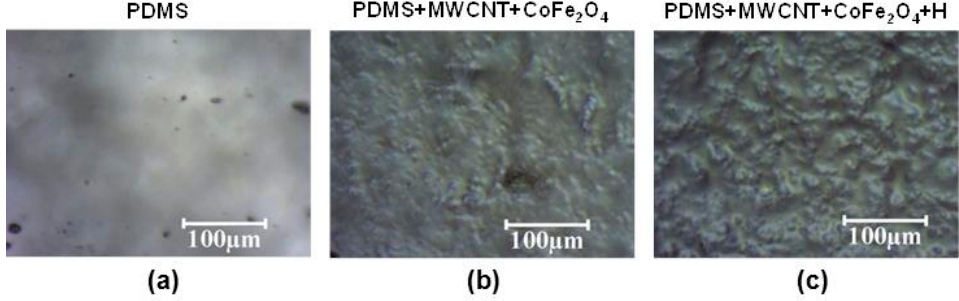
Figure 2. Optical microscopies: ( a ) PDMS. ( b ) PDMS + MWCNT (1%) + Fe 2 CoO 4 (2%). ( c ) PDMS + MWCNT (1%) + Fe 2 CoO 4 (2%) + H .